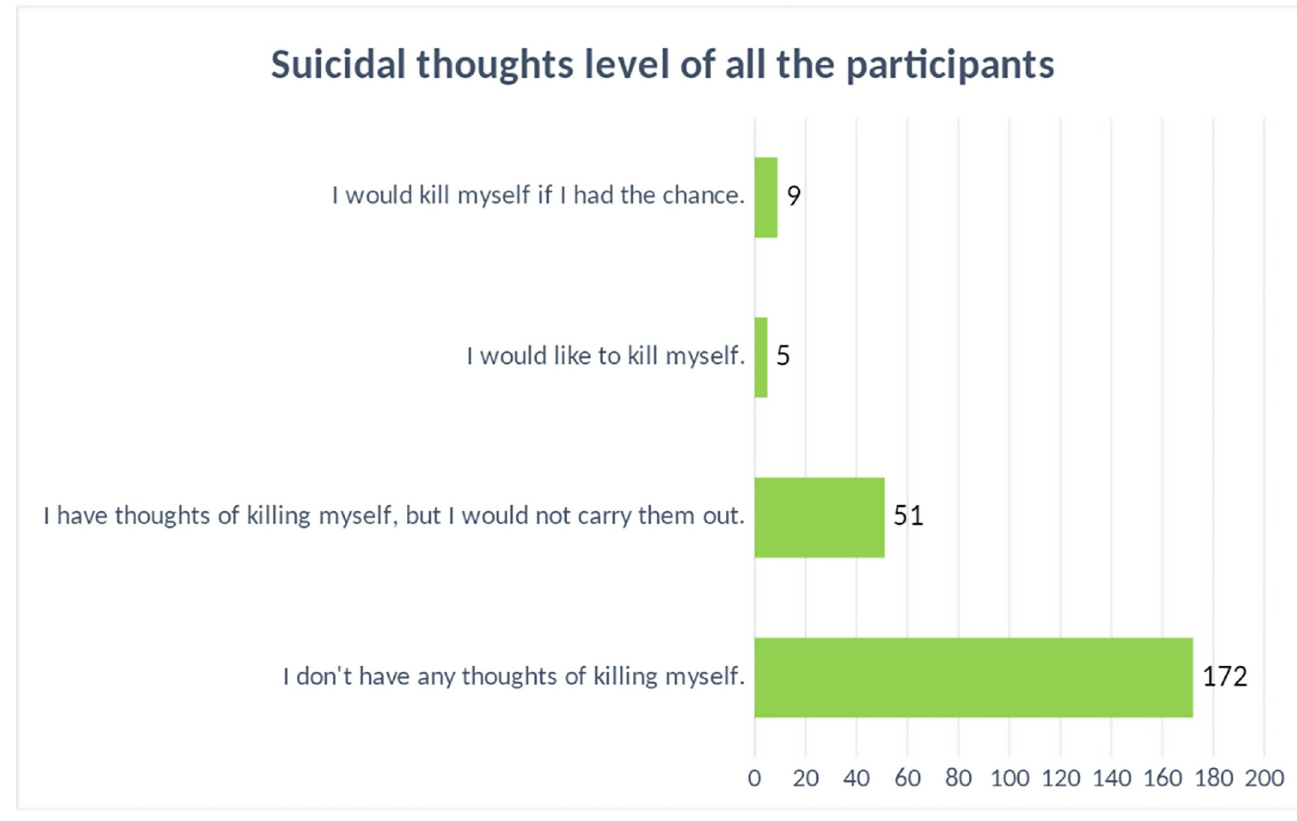
Fig 3. Suicidal thoughts levels of all the